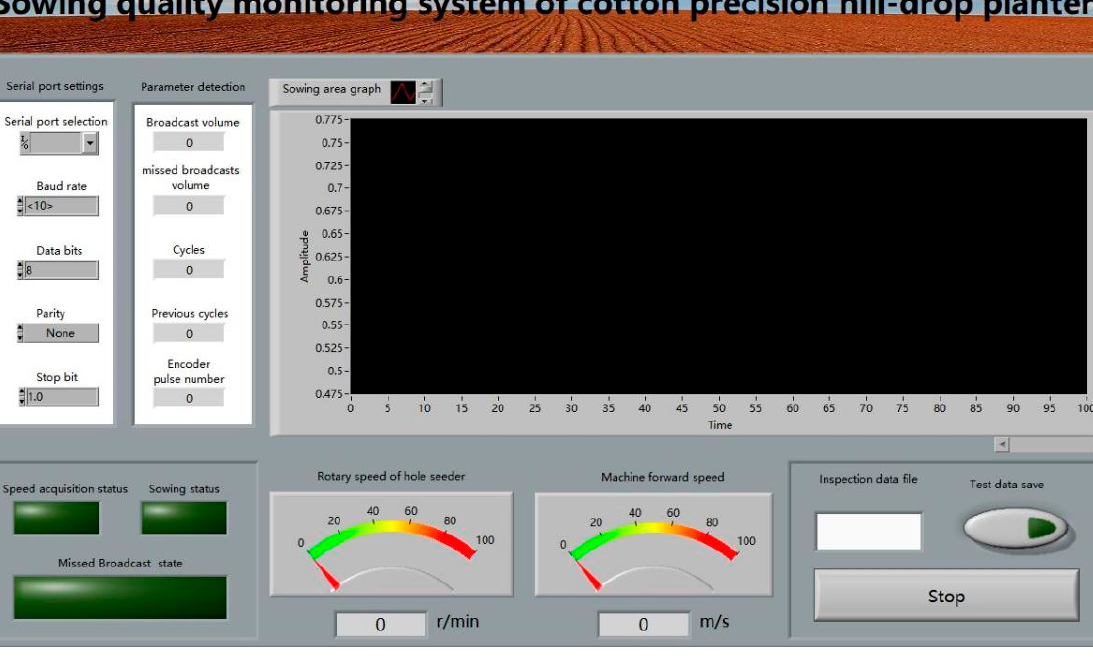
Figure 4. The interface of sowing quality monitoring system of cotton precision planter.